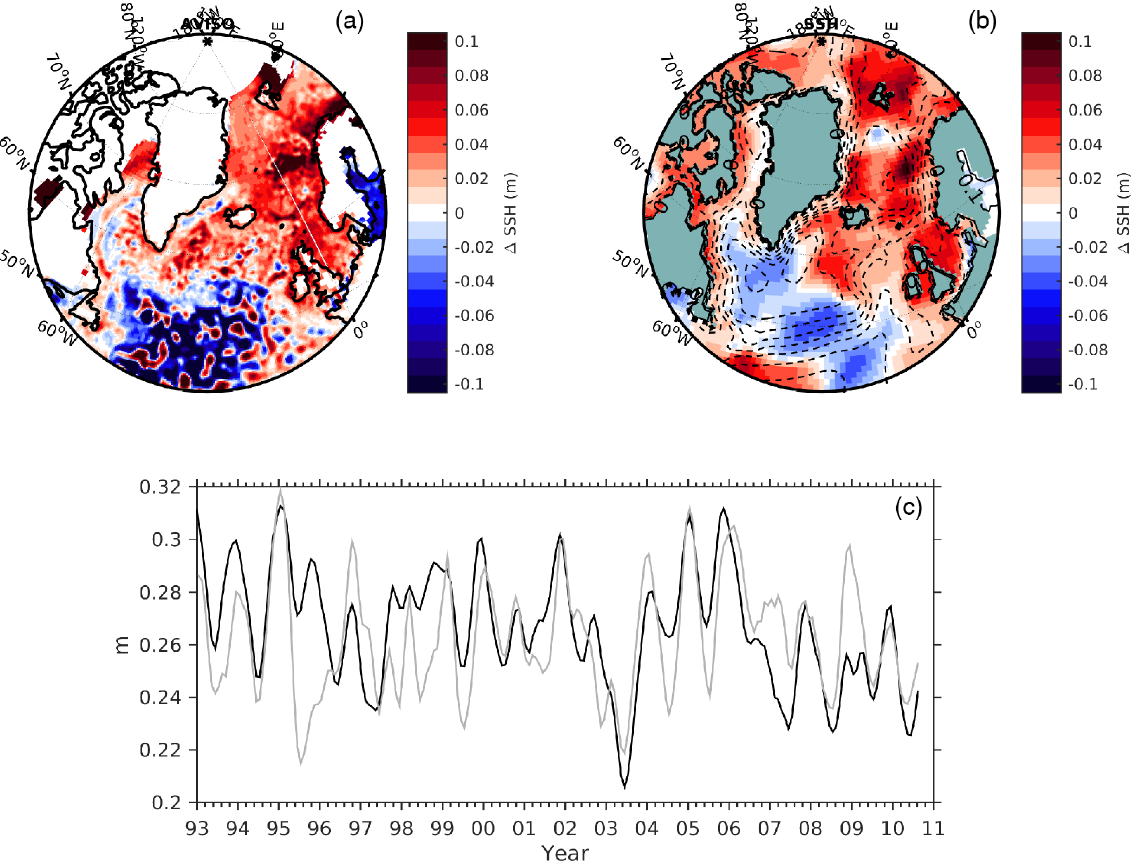
Figure 4. Observed AVISO (http://www.aviso.oceanobs.com/duacs/) mean sea-level anomaly (MSLA) for JFM 2003 (a) compared with modelled (b) sea-surface height anomaly for JFM 2003 relative to the climatic winter average for the period 1996–2010. Contours in (b) represent closed streamlines of the vertically averaged model circulation. In (c) we compare time series of sea-surface height difference across the IFR between model (black) and observations (grey). The observed sea-surface height difference is based on an average of AVISO mean sea-level anomalies for four model grid points west of the IFR minus four points east of the IFR, approximately at the 2500m isobaths. Observations have been artificially offset to fit the model mean